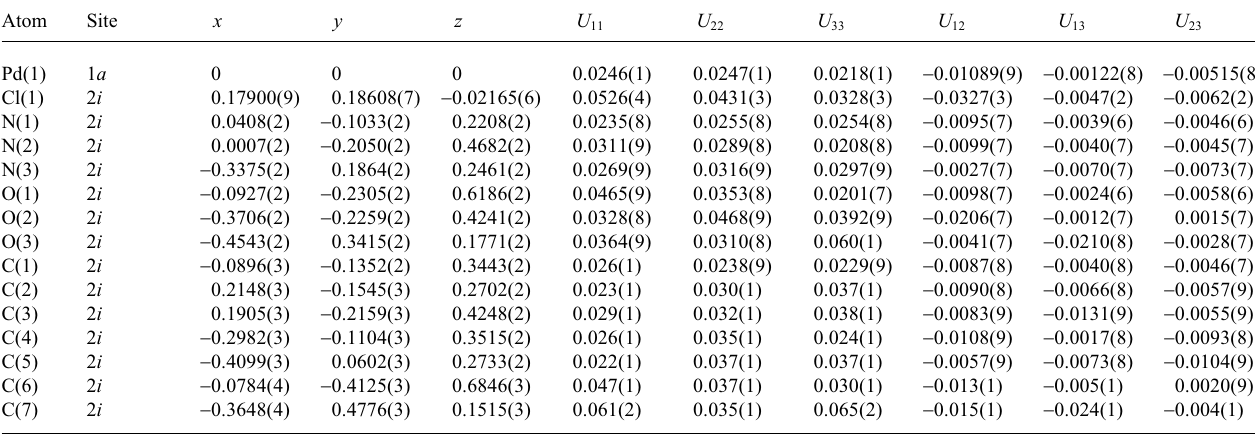
Table 3. Atomic coordinates and displacement parameters (in Å 2